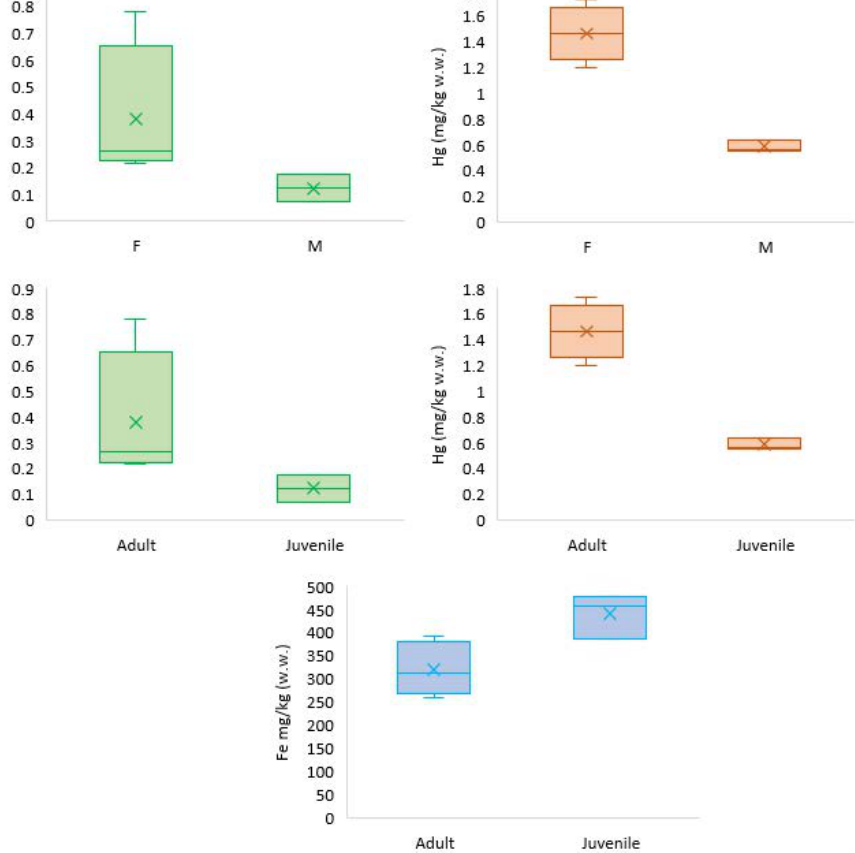
Figure 3. Statistically significant differences were detected in blubber and kidney by age and sex. No sex-related difference was found in any of the tissues for Fe. By contrast, age- related differences were found in the kidney ( p = 0.038), with juveniles presenting higher levels of Fe with respect to adults (Table 3). This difference is supported by a negative correlation between kidney Fe concentrations and NBFL and NTL ( p = 0.0414 and p = 0.0239, respectively).